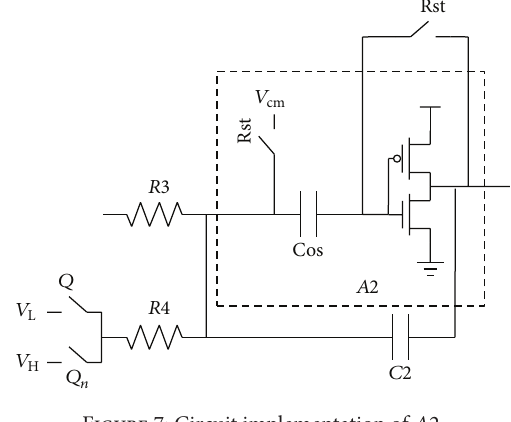
Figure 7: Circuit implementation of 𝐴2 .